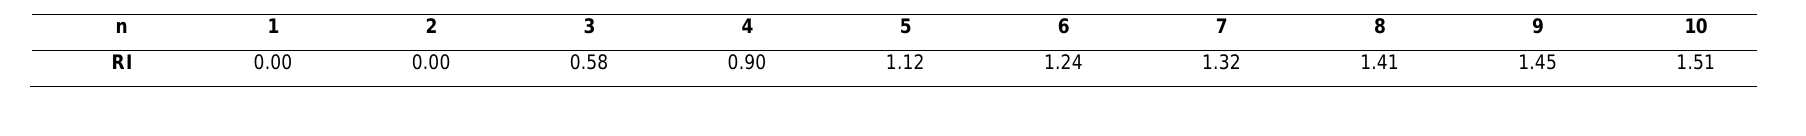
Table 14. Random index (RI) value according to n change